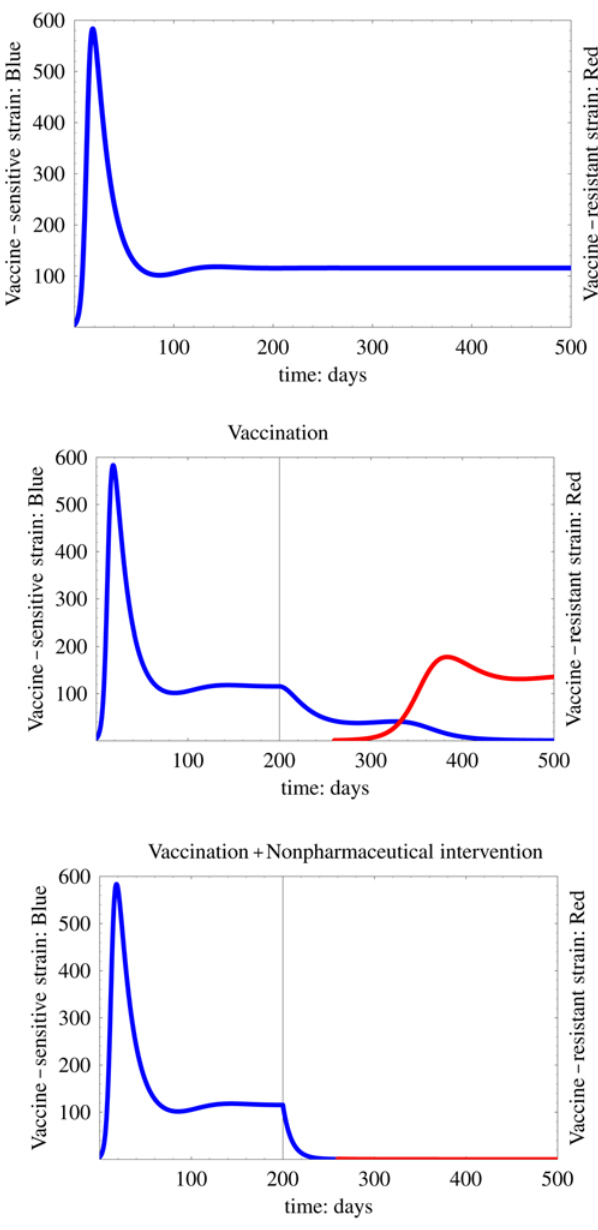
Figure 7. Time-course of the spread of the disease with vaccination and non-pharmaceutical interventions: We calcu- late epidemic curves with a vaccination program for 500 days. The vaccination program and non-pharmaceutical intervention are started after the vaccine-sensitive strain becomes endemic (around 200 days). We assume that the vaccine-resistant strain occurs after the start of vaccination (around 260 days). The top, middle, and bottom figures respectively depict time courses of infection without the vaccination program, with only the vaccination program, and with both the vaccination program and the non-pharmaceutical intervention. The blue and red curves respectively represent the number of infected individuals with vaccine-sensitive and vaccine-resistant strains. We assume that the prevalence rate of vaccination program is p =0.5, the loss of protection effectiveness is s